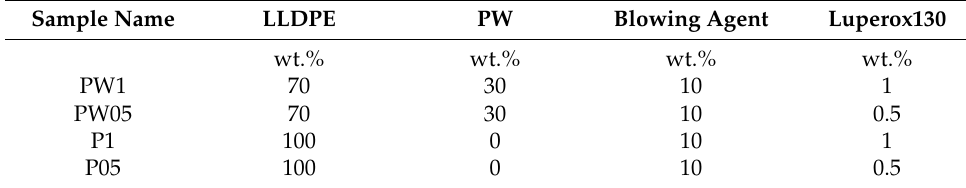
Table 1. Composition of prepared